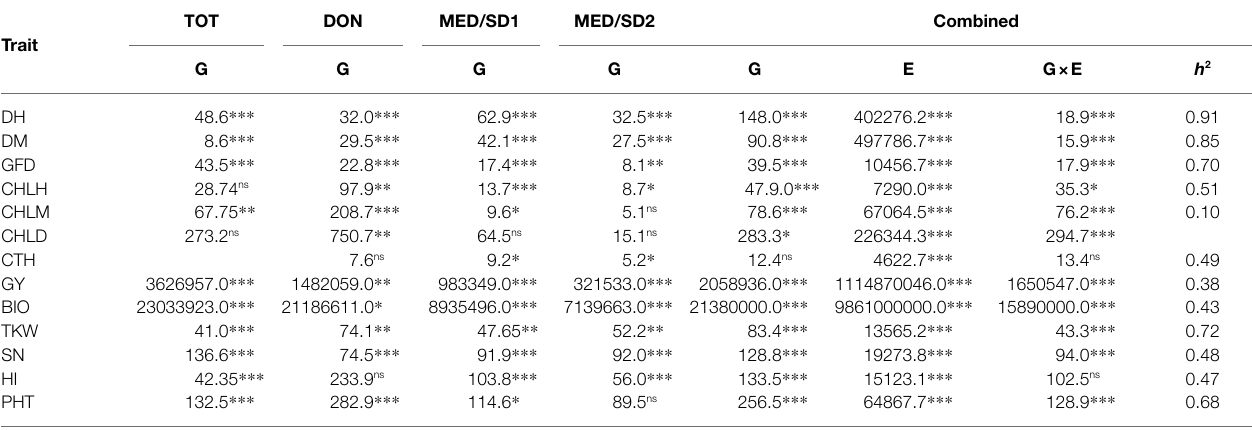
TABLE 1 | Sum of squares of the 13 evaluated traits in the multiple derivative lines grown at Tottori (TOT), Dongola (DON), Wad Medani first sowing date (MED/SD1) and Wad Medani second sowing date (MED/SD2). TOT Trait